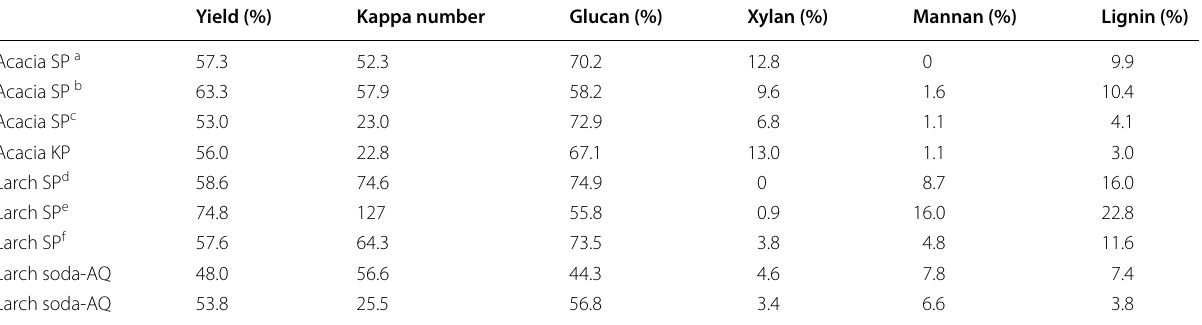
Cooking conditions a pH 1.4, 145 ℃ for 0.5